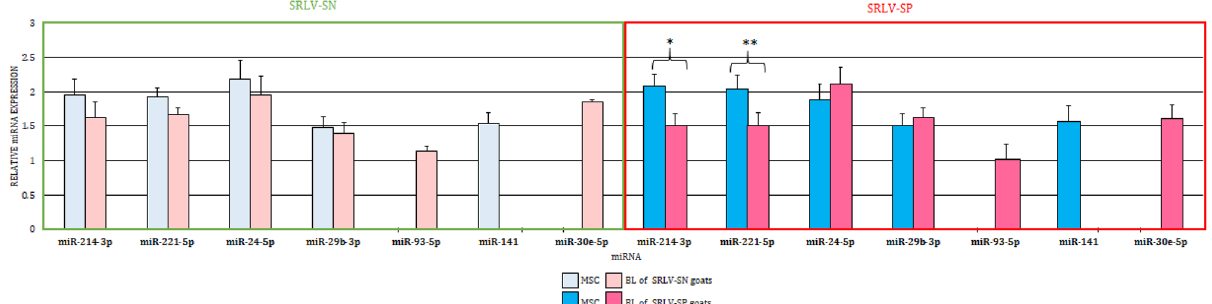
Figure 1. Differences (LSMEANS, ± SE) between miRNA levels in milk cells and blood leukocytes of SRLV- seronegative and SRLV-seropositive goats. The value within the same miRNA with star(s) differs significantly between milk somatic cells (MSC) and blood leukocytes (BL): * at p ≤ 0.05 and ** at 0.05 < p ≤ 0.01. SRLV-SN small ruminant lentivirus seronegative goats, SRLV-SP small ruminant lentivirus seropositive